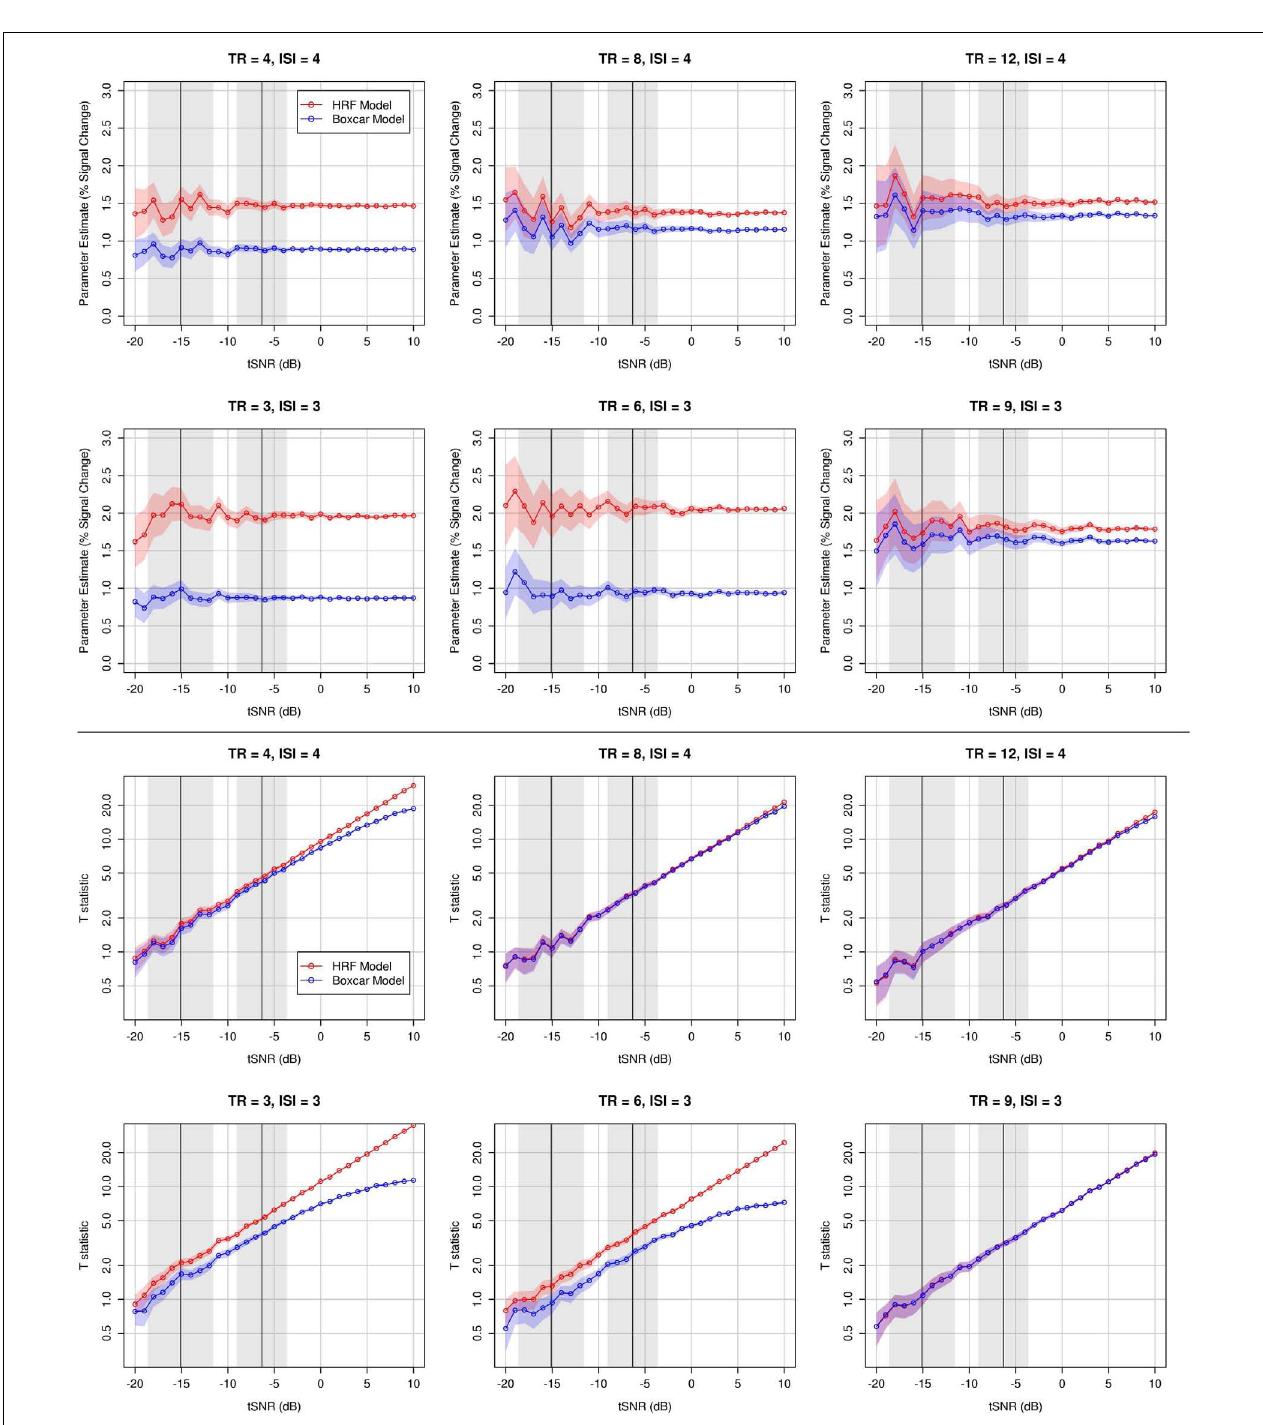
substantially more statistically reliable model than a classic boxcar model, an effect that is enhanced with increasing tSNR.The range of actual tSNR values observed in the experimental validation of these results are illustrated in the shaded gray domains: left domain, mean and 95% confidence interval across participants of the mean tSNR within left Heschl’s gyrus; right domain, mean and 95% confidence interval across participants of the maximum tSNR in left Heschl’s gyrus. Note that the plots showing t -statistics are effectively log–log